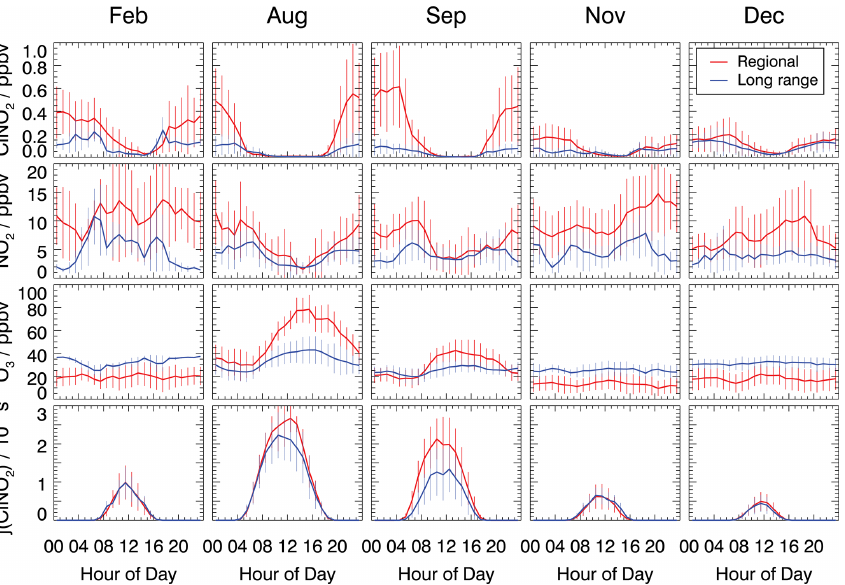
Figure 3. Mean diurnal profiles of ClNO 2 , NO 2 , and O 3 concentrations and ClNO 2 photolysis frequencies. Trace gas concentrations were measured in the inflowing air or values measured inside the chamber were used to back-calculate the concentrations in the inflowing air. Data are 1h average values, with error bars denoting 1 σ standard